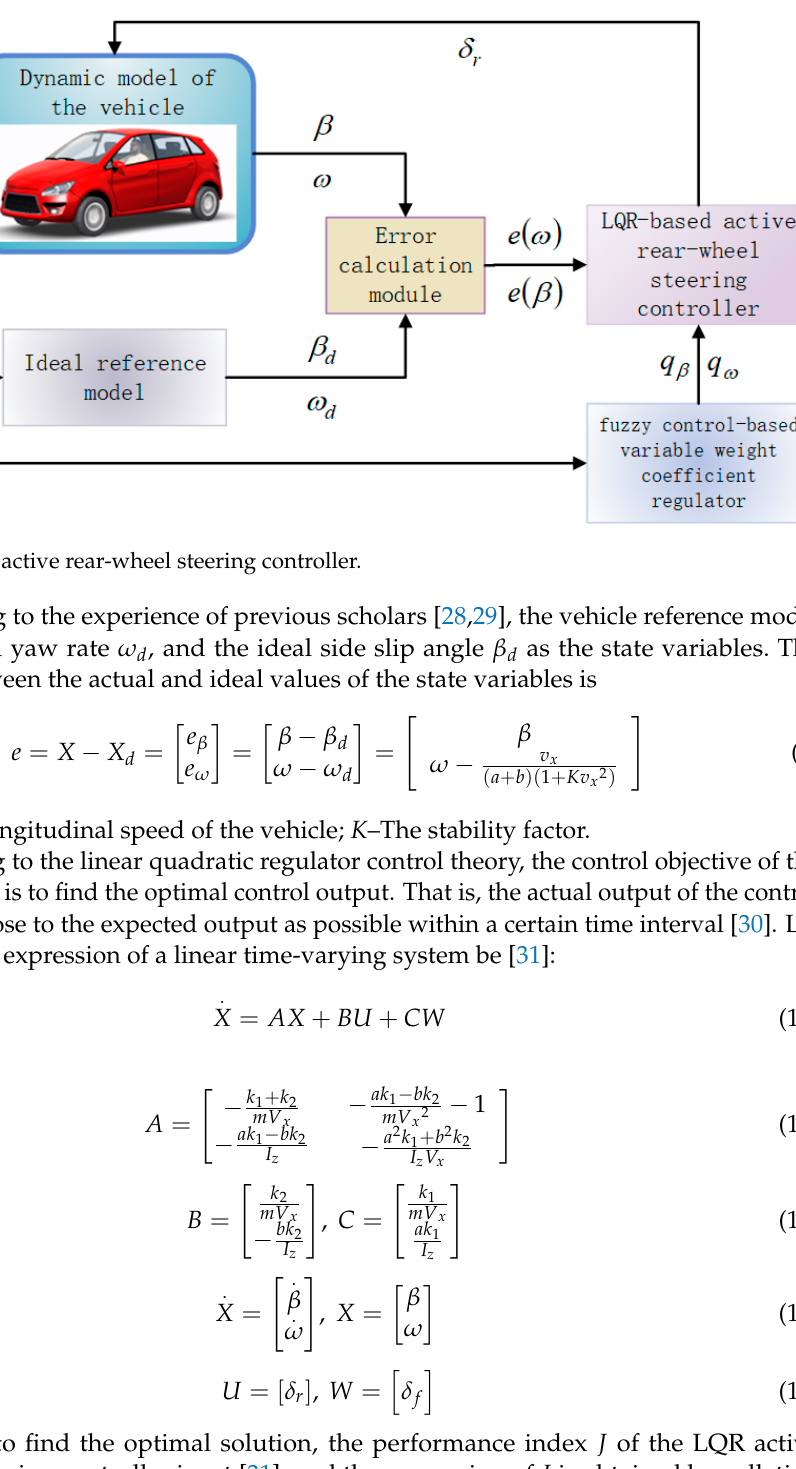
11 of 26 Figure 4. Structure block diagram of dynamics coordinated control system.